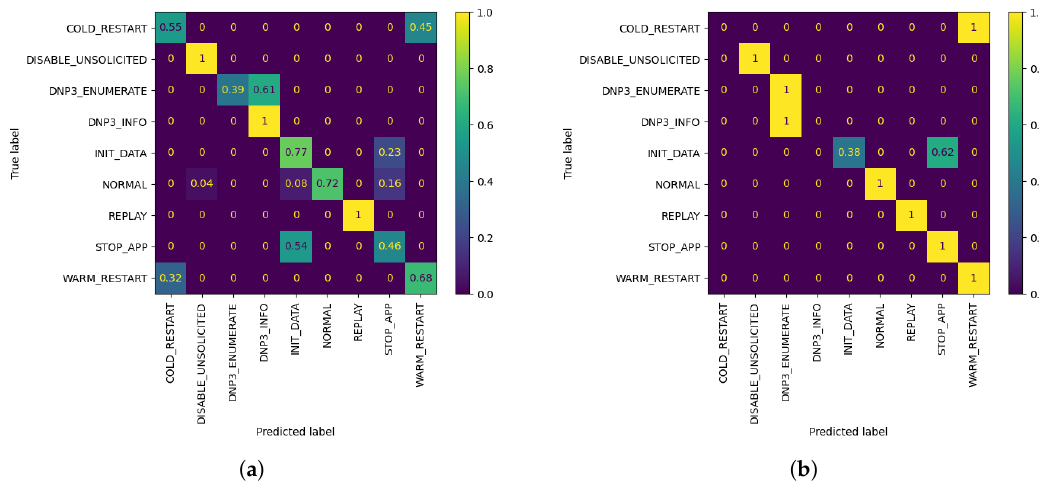
Figure 7. W3 Confusion Matrices. ( a ) W3’s evaluation of global FL model after r = 3 using its evaluation dataset; ( b ) W3’s evaluation of customized model by AL, after Q = 10 queries, using its evaluation dataset.